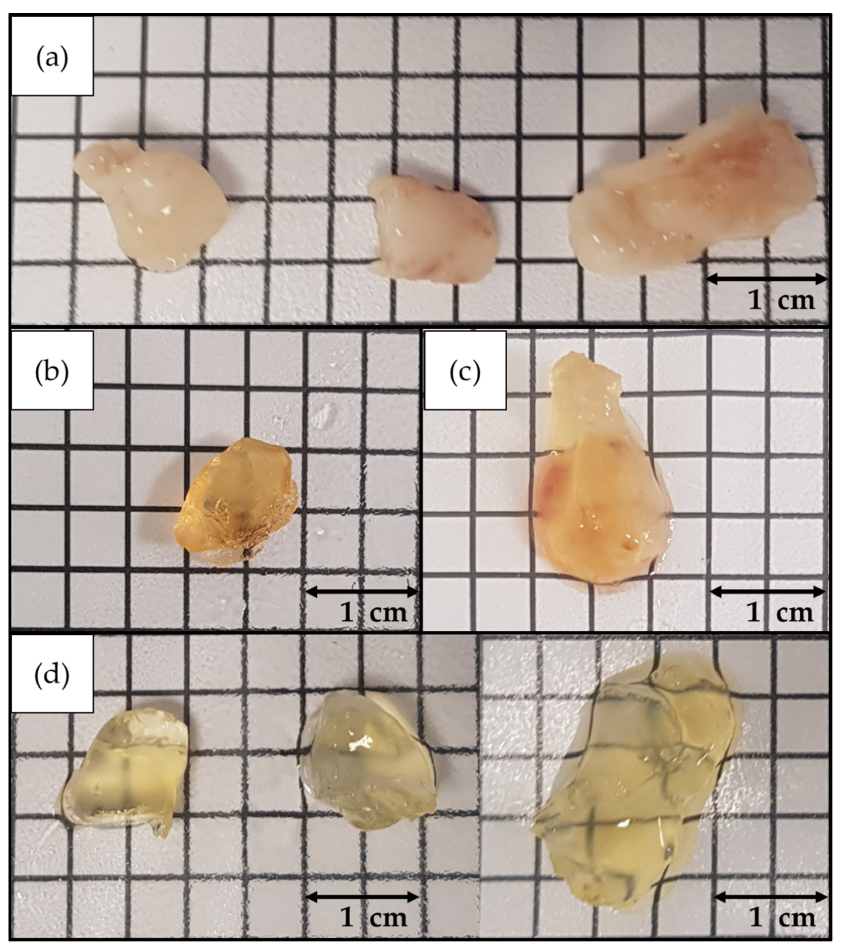
Figure 6. Cell line-derived melanoma xenograft model samples ( a ) before starting the tissue clearing protocols, ( b ) after completing the BABB protocol, ( c ) after completing the TDE protocol, ( d ) after completing the CUBIC protocol.